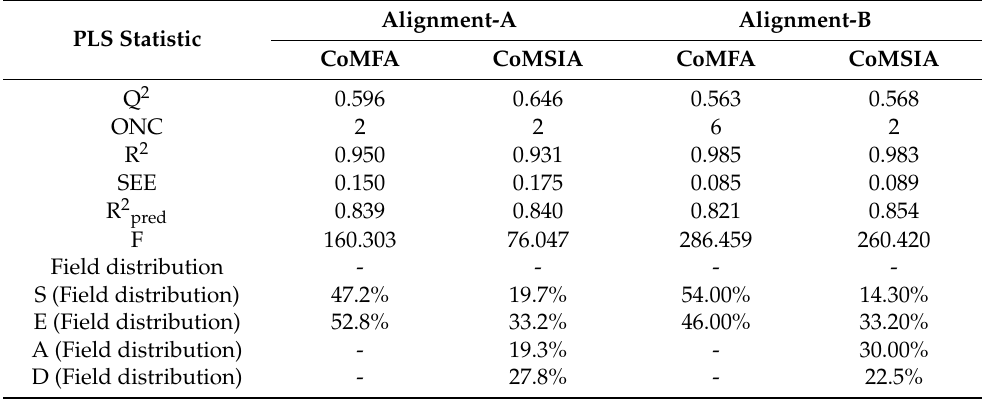
Figure 1. The studied c-Met inhibitors. ( A ) is the common atoms (represented as balls) used for molecular alignment in compound 4 . ( B ) is the atom-based alignment figure (Alignment A). ( C ) is the docking-based alignment figure (Alignment B). Table 2. Summary of the CoMFA and CoMSIA models for alignment-A and alignment-B.